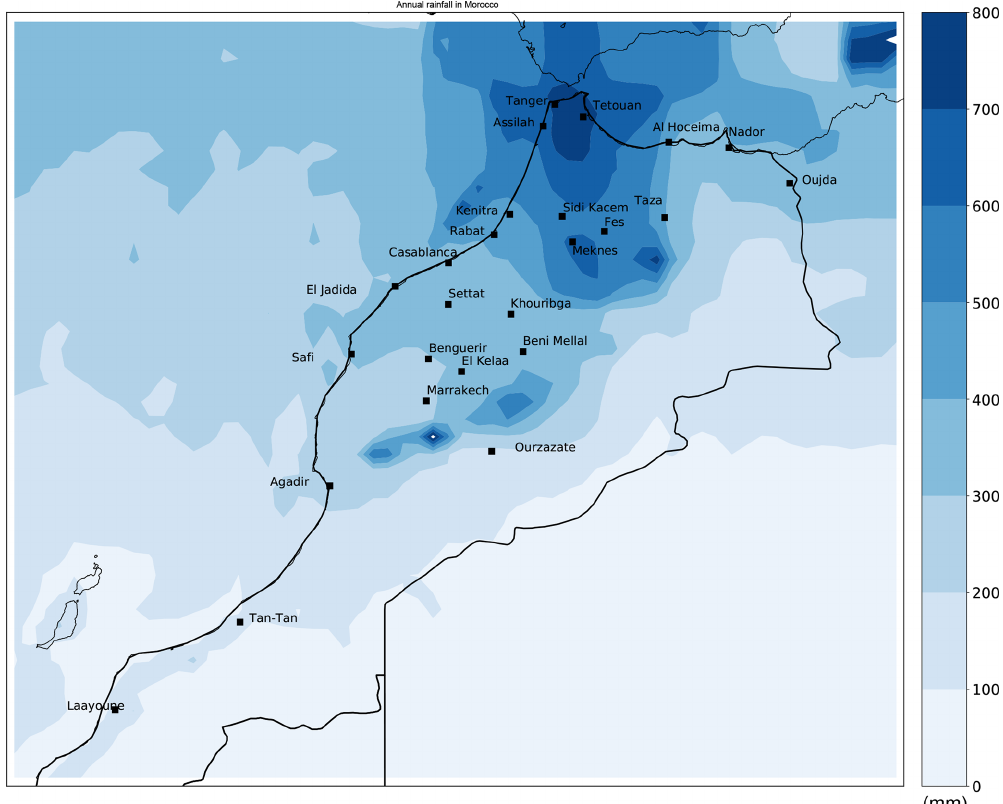
Figure 1. Annual precipitation (in millimeters) in Morocco using Tropical Rainfall Measurement Mission (TRMM) data.